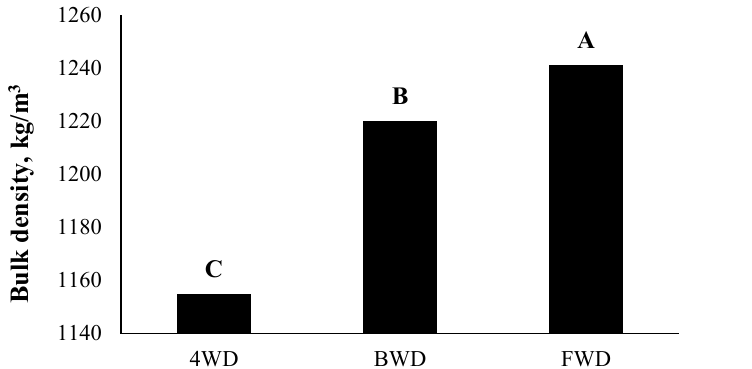
Figure 3. Changes in bulk density due to changes in the drive system (different letters shows significant difference between treatments).